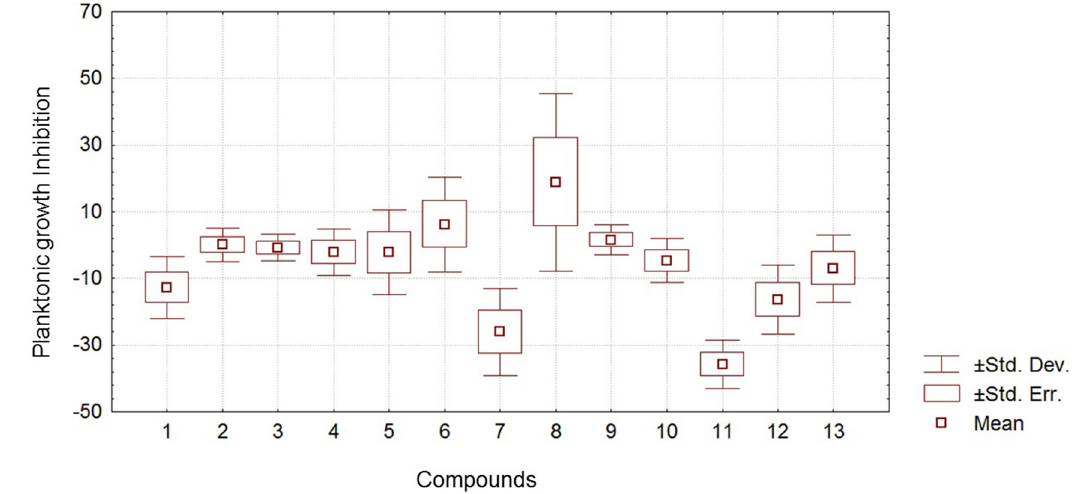
Figure 3- Statistical results for each compound on inhibition of planktonic growth obtained by